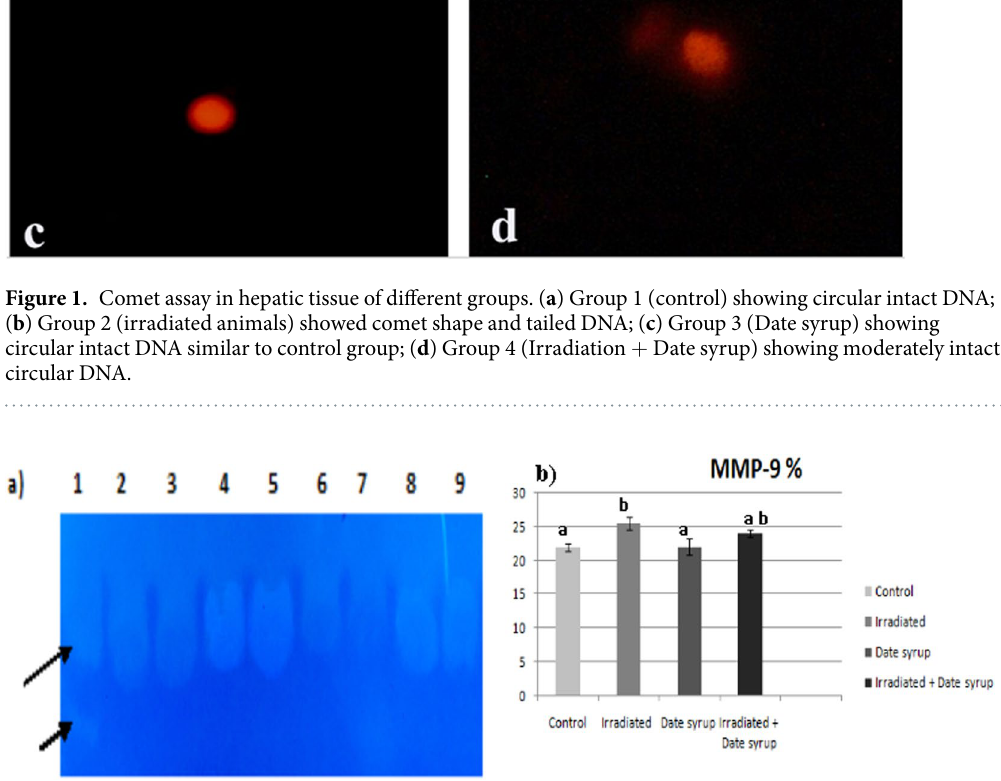
Figure 2. Activity of MMP-9 and gelatin zymography of enzyme activity in control and treated groups ( a ) A cropped zymogram gel for identification the activity of MMP-9. Lanes 2–3 = control; lanes 4–5 = Irradiated; lanes 6–7 = Date syrup; lanes 8–9 = Irradiated + Date syrup. Positive control shown in lane 1 is from baby hamster kidney cells transfected with active MMP-9 (86 kDa) and MMP-2 (66 KDa) that are indicated by arrows. ( b ) Quantification of enzyme activity shown as % of bands intensity, the zymogram was quantified by MyImage Analysis Software; Thermoscientific TM . Values are presented as mean ± SE. Means above column of histogram with different letter (a–b) are significantly different at (P <